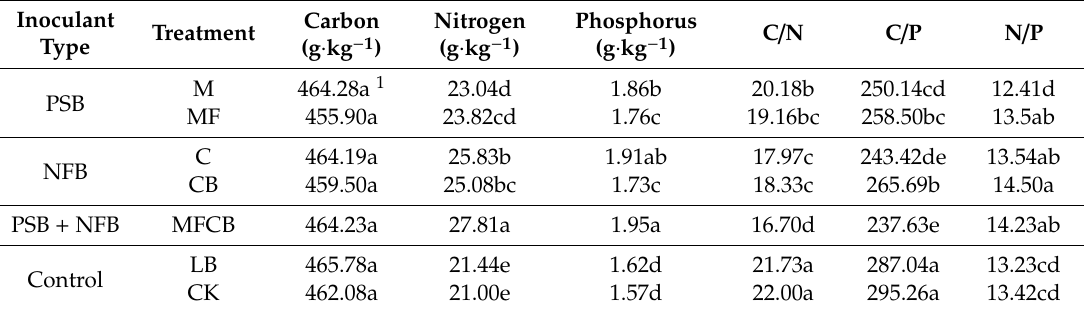
Table 2. Contents of total carbon, nitrogen, phosphorus, and their ratios in C. paliurus